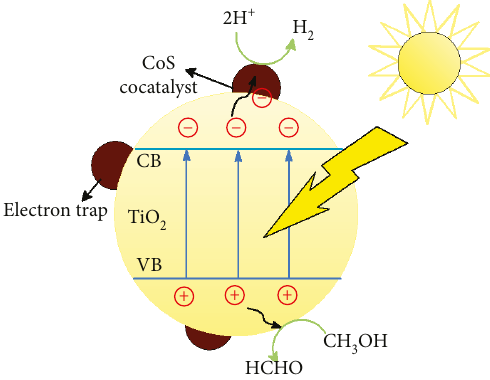
Figure 8: Schematic diagram of charge transfer